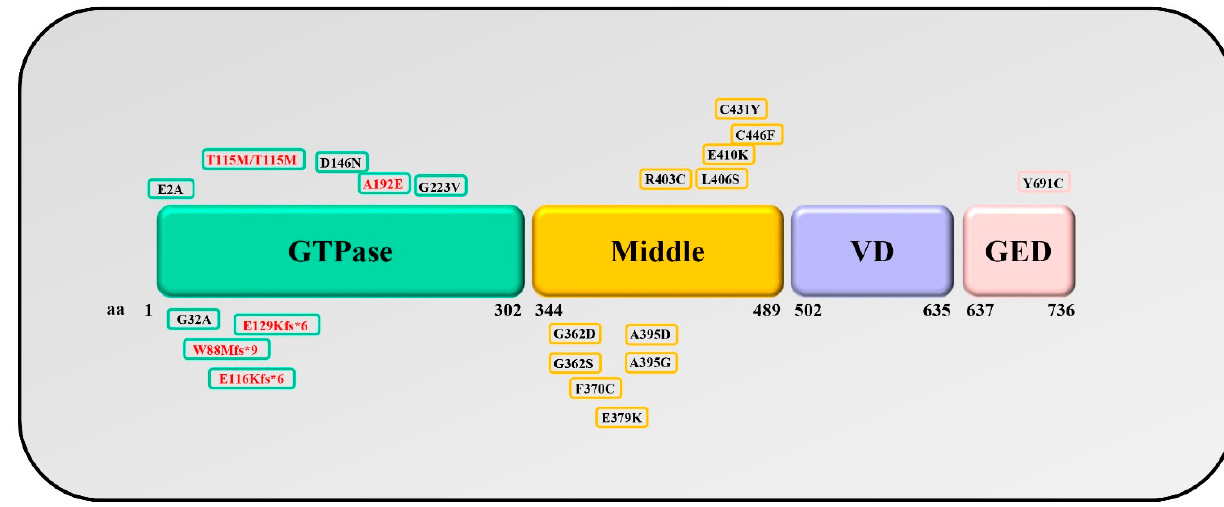
Figure 2. Schematic representation of Drp1 domains . Distribution of the mutations reported up to date. In red, homozygous or compound heterozygous variants; in black, dominant-negative variants. It should be noted that most of the dominant variants are located in the middle domain. GED, GTPase effector domain; VD: variable domain.